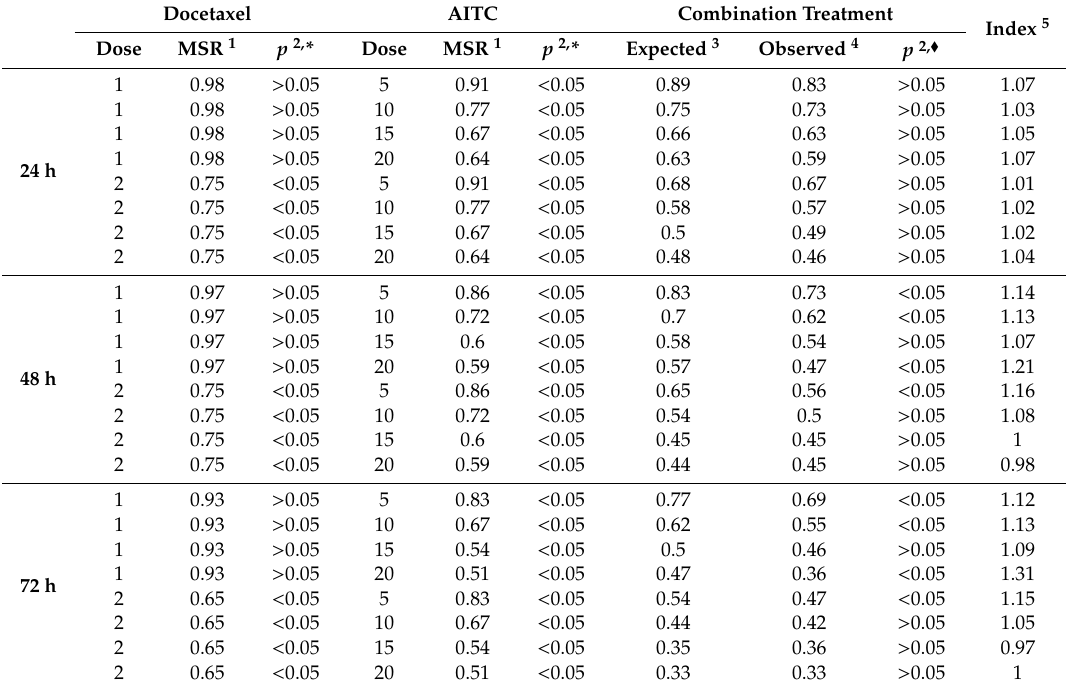
Table A2. Analysis of synergy between AITC and DOCE calculated by survival rate for DU 145